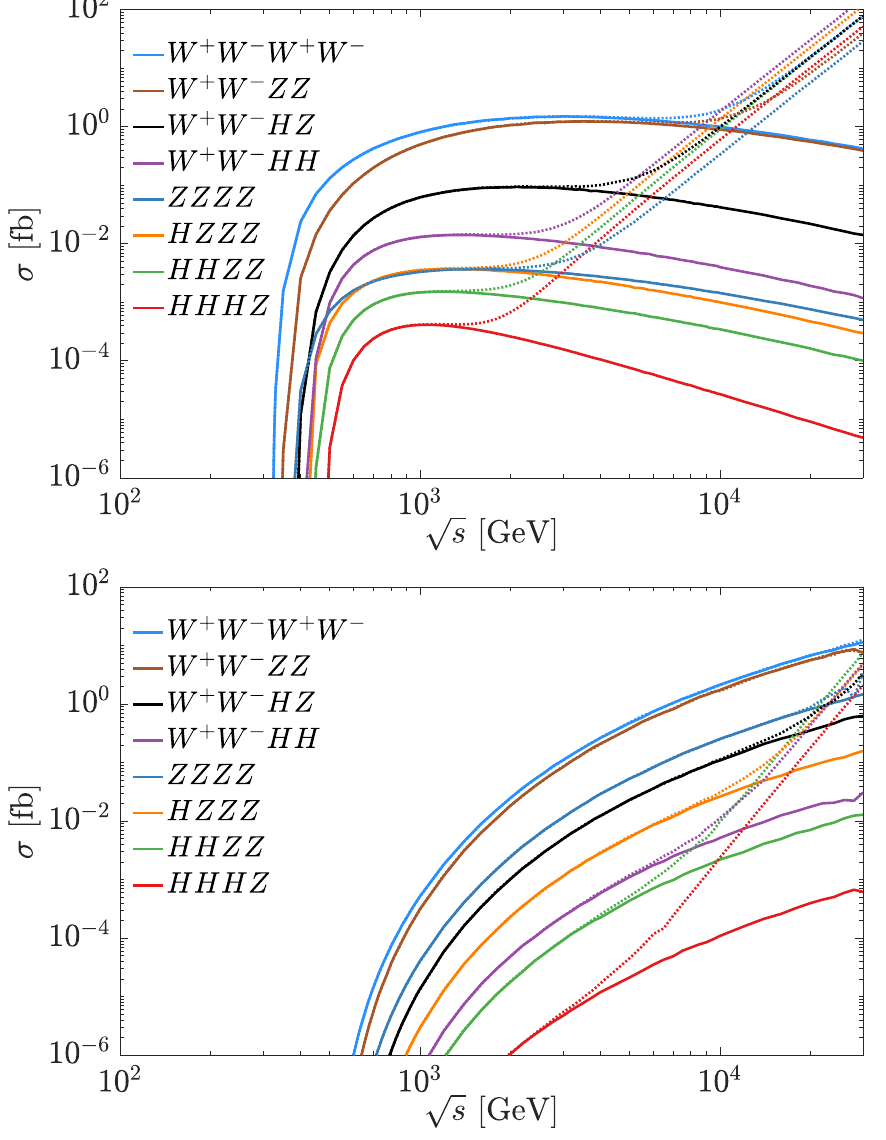
Figure 7 . The cross sections of four-boson production at a µ + µ − collider via (a) annihilation µ + µ − → 4 B and (b) the (charged) vector boson fusions (VBF), µ + µ − → ν µ ¯ ν µ X as functions of √ s . The solid and dotted lines are for the results with muon Yukawa coupling as the c.m. energy κ µ = 1 and κ µ = 0 (2) ,